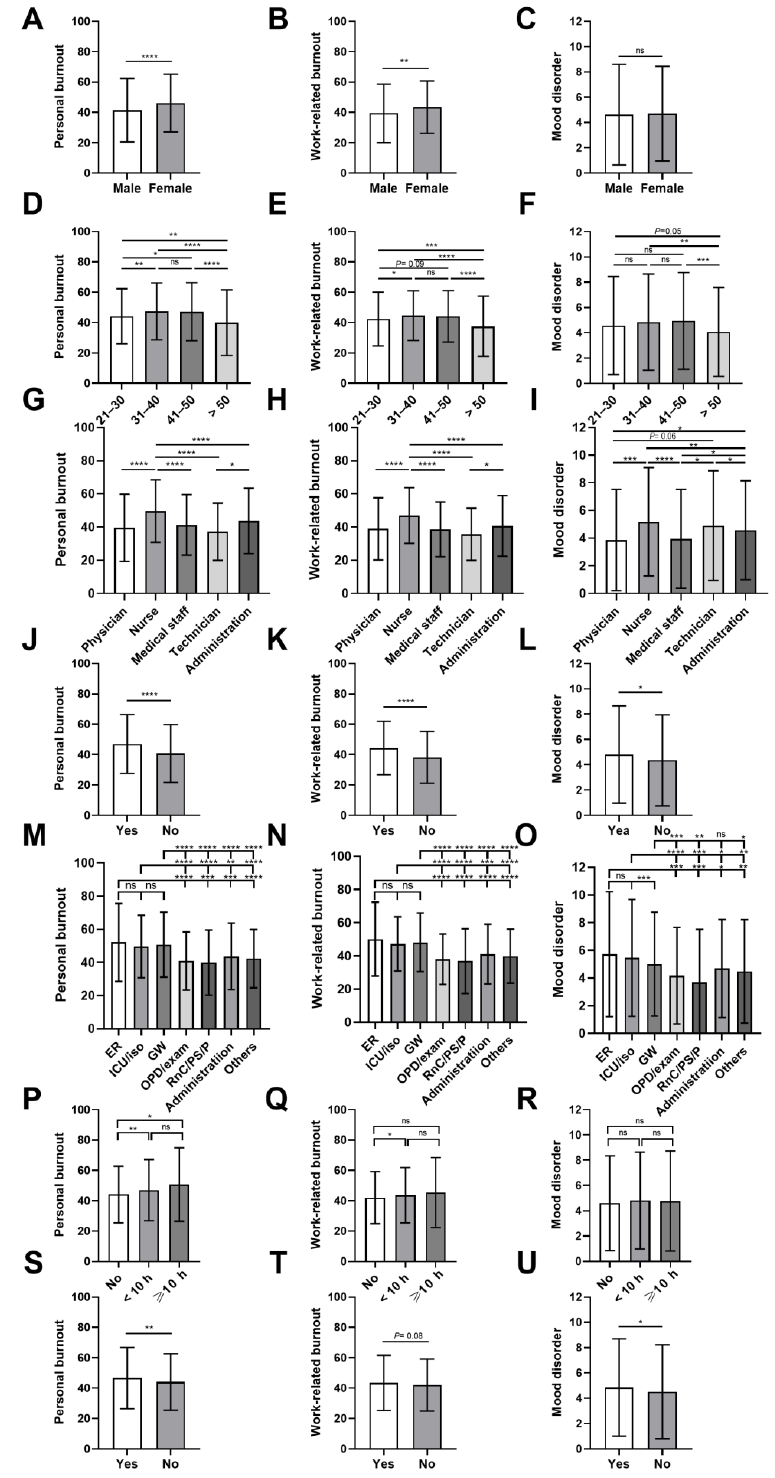
Figure 1. Personal burnout, work-related burnout, and mood disorder scores (mean ± SD) and comparisons between subgroups. The subgroups were stratified by gender (panels A – C ), age ( D – F ), professional category ( G – I ), patient contact ( J – L ), working space/area ( M – O ), extra working hours during the COVID-19 pandemic ( P – R ), and extra duties for COVID-19 ( S – U ) (*, p < 0.05; **, p < 0.01; ***, p < 0.001; ****, p < 0.0001; ns, not significant). ER, emergency room; GW, general wards; ICU/iso, intensive care unit or isolation wards; OPD, outpatient department; RnC/PS/P, registration and cashier/patient